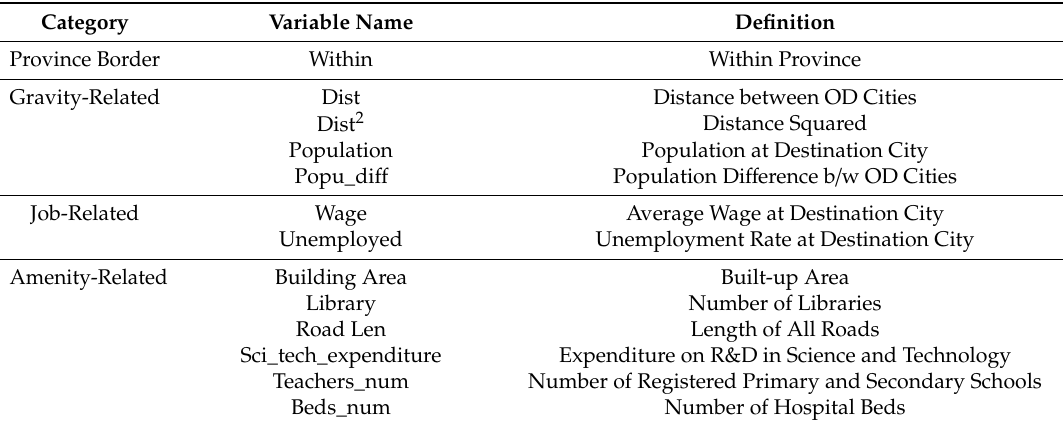
Table A2. Definition of city-level variables.